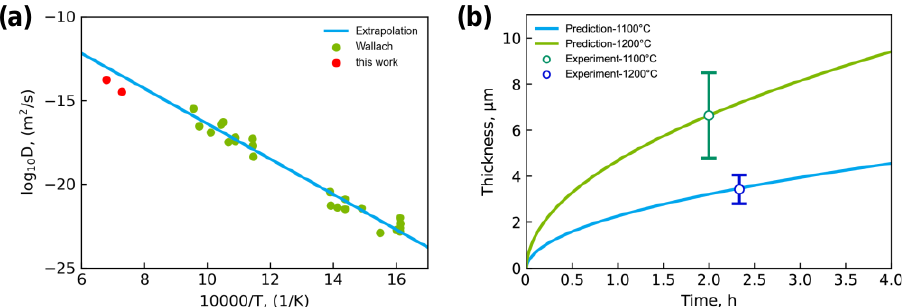
Figure 6. ( a ) Comparison between the presently evaluated interdiffusion coefficients of Nb 3 Sn at 1100 °C and 1200 °C and the low-temperature data from Wallach [23]; ( b ) Model-predicted thickness of the Nb 3 Sn layer as function of annealing time for the Nb/Sn LSDCs, compared with the experimental data in the present work.